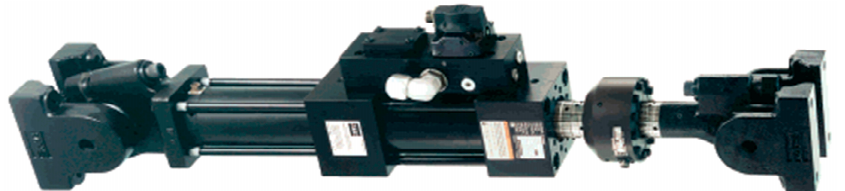
Figure 18. The hydraulic actuator used in the experiment (maximum capacity 50 kN, manufactured by MTS).